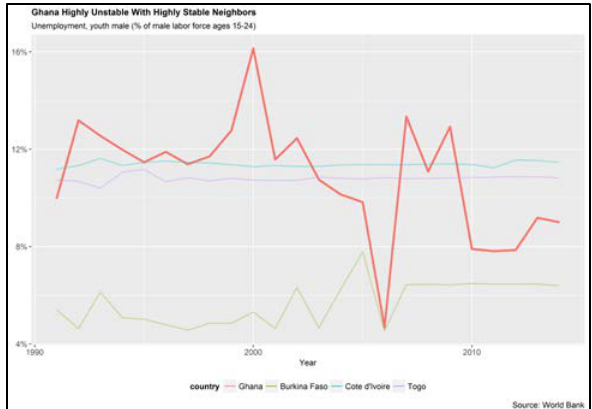
Figure 8. Ghana Identified with the 2 nd